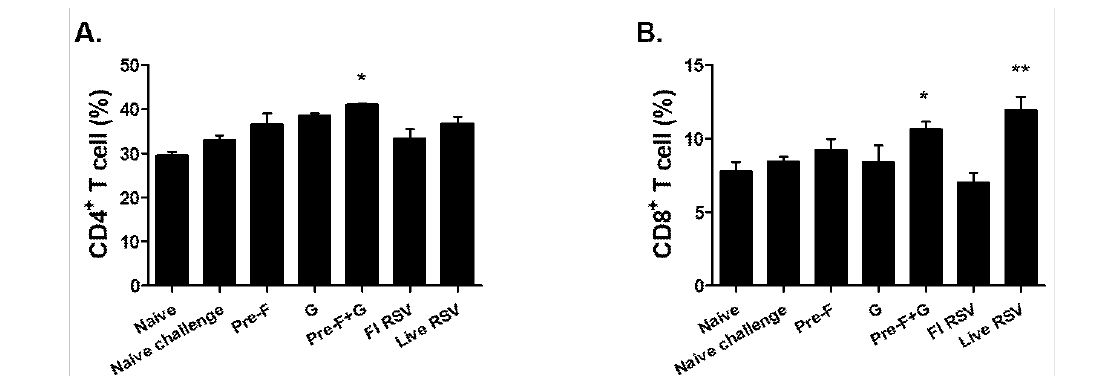
Figure 4. Eosinophil and IL-4 producing CD4 + T cell counts. To isolate the eosinophil and IL-4-producing CD4 + T cell phenotypes in the lung, lung cells were stained with fluorescent markers (CD11b, CD125, Siglec-F, CD3, CD4, and IL-4) and analyzed by BD Accuri C6 software ( A – C ). VLP-immunized groups showed significantly lower levels of eosinophil compared to naïve challenge (( B ), * p < 0.05). A significantly lower level of IL-4-producing CD4 + T cells was observed in VLP-immunized mice than naïve challenged mice (( C ), * p < 0.05).